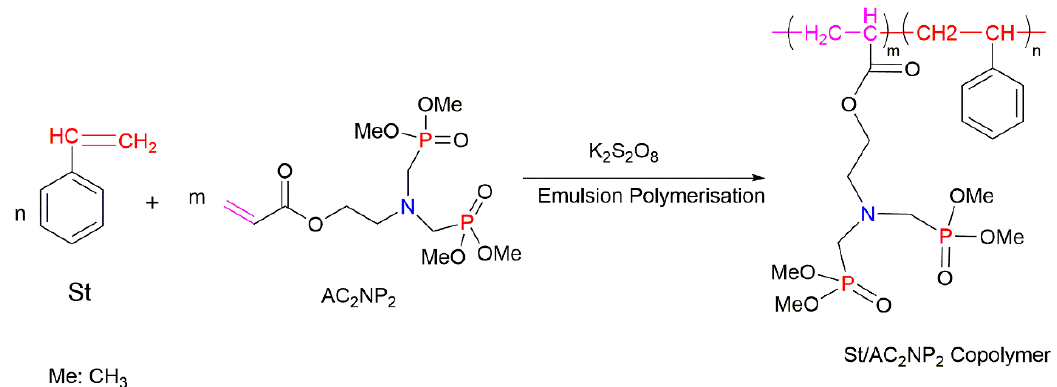
Figure 25. The Kabachnik–Fields reaction to synthesise ethyl- N,N -tetramethyl-bis(phosphonate)- bis(methylene)amine acrylate (AC 2 NP 2 ) [107,119].